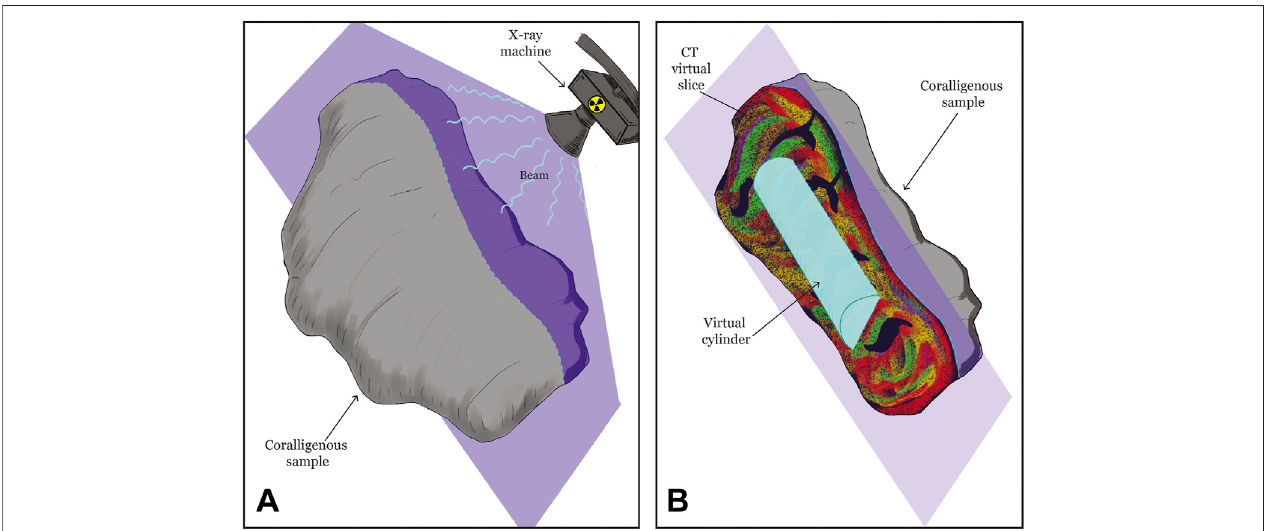
FIGURE 2 | Procedure scheme for the computed tomography and the volume calculation. (A) The acquisition phase, with the indication of one slice (in violet) as example. Inner structure is reconstructed by radiating using X-ray, in the three axes, adjacent slices of 0.625 mm thickness (step). The software then recomposed the complete structure in 3 dimensions. (B) Each slice is visualized and fragmented via thresholding by using AMIRA-Avizo software. In the inner structure, a virtual cylinder (light blue) for the volume calculation has been